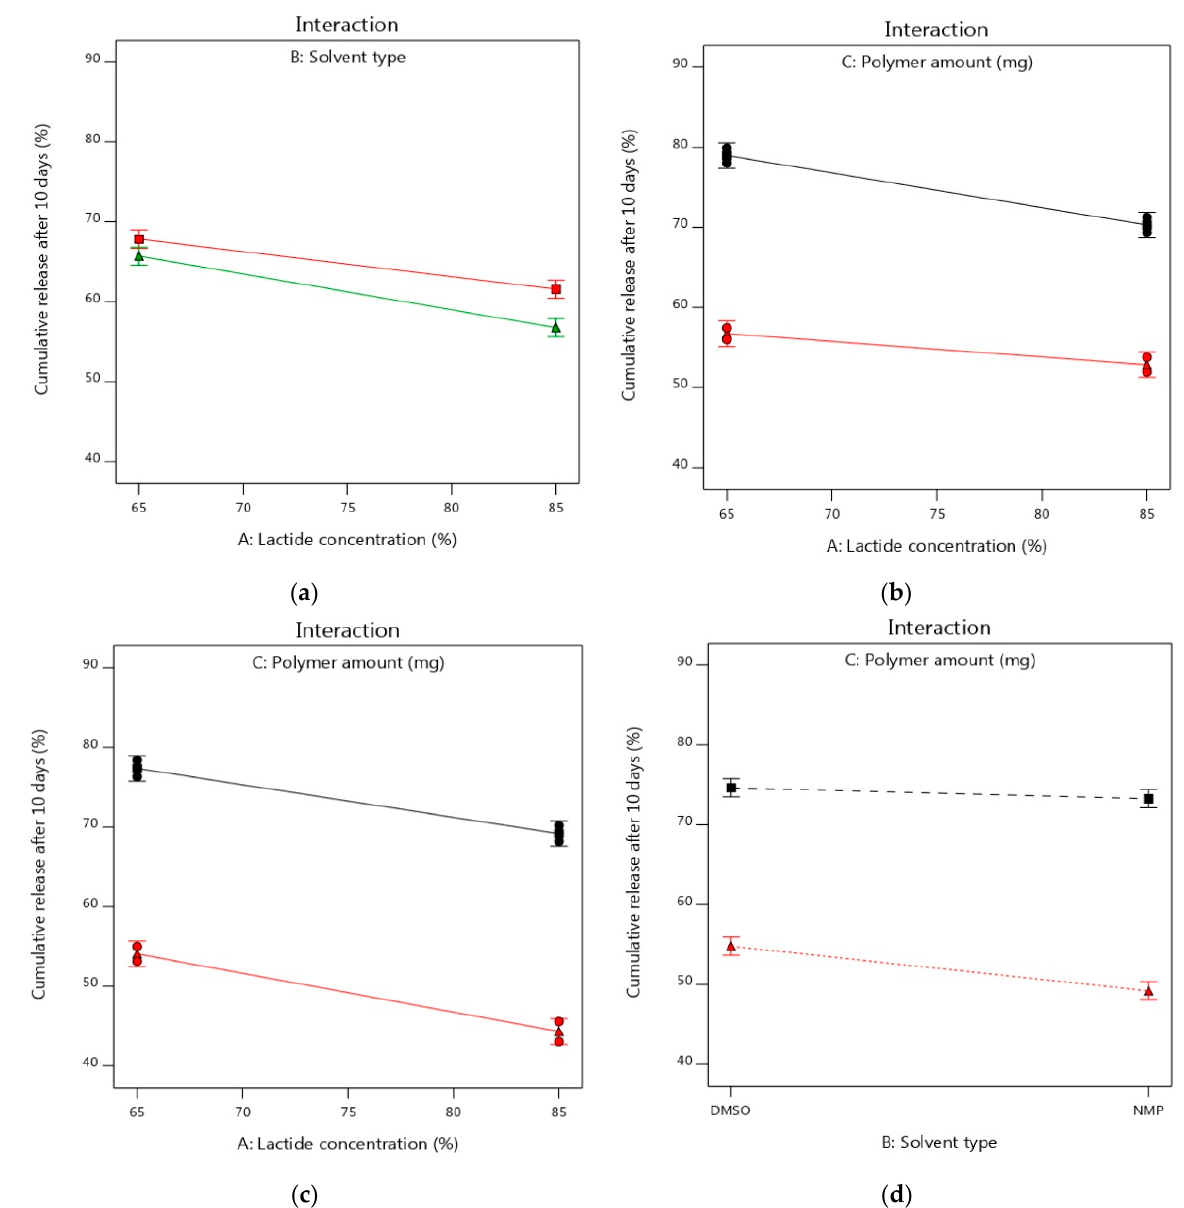
Figure 6. Interaction plots of influence of independent factors on Y 2 response ( a ) effects of A and B ( b ) effects A and C using DMSO ( c ) effects of A and C using NMP ( d ) effects of B and C. Figure 5a: the upper line refers to DMSO and the lower line refers to NMP. Figure 5b,c,d: the upper black lines refer to PLGA (187.5 mg) and the lower red lines refer to PLGA (312.5 mg).